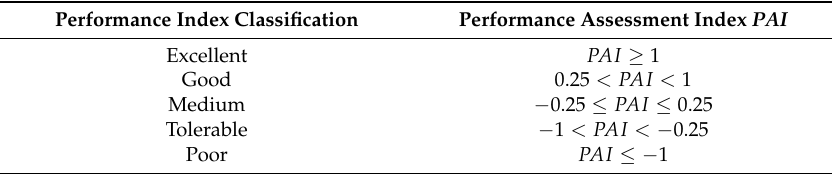
Table 2. Classification of performance assessment